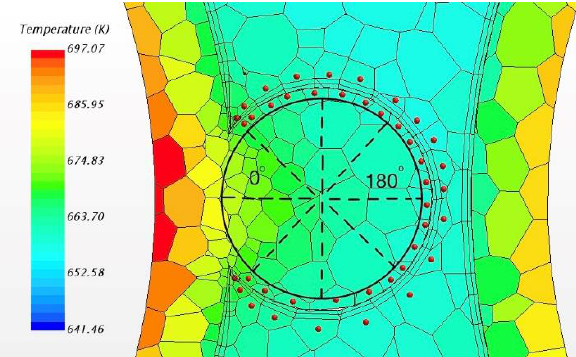
Figure 9. The direction of the angle and temperature spots.